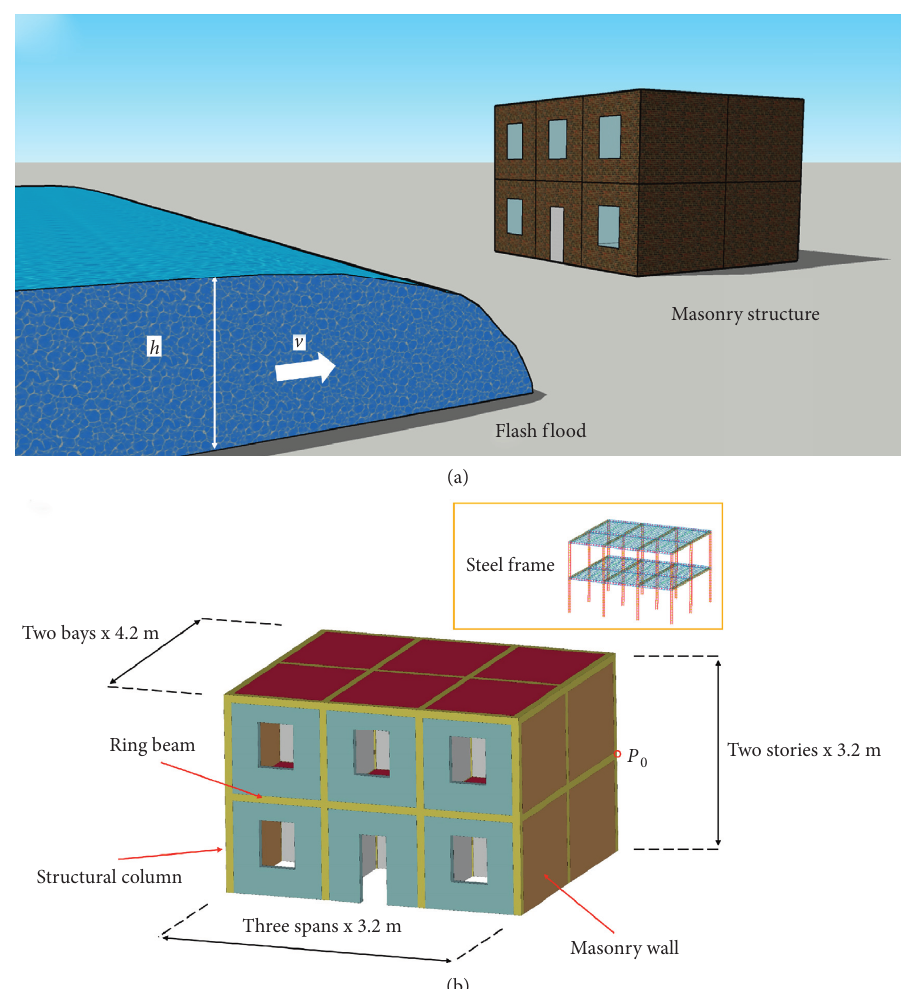
Figure 3: Schematic diagrams: (a) global disaster scenario and (b) finite element model of the masonry building with structural